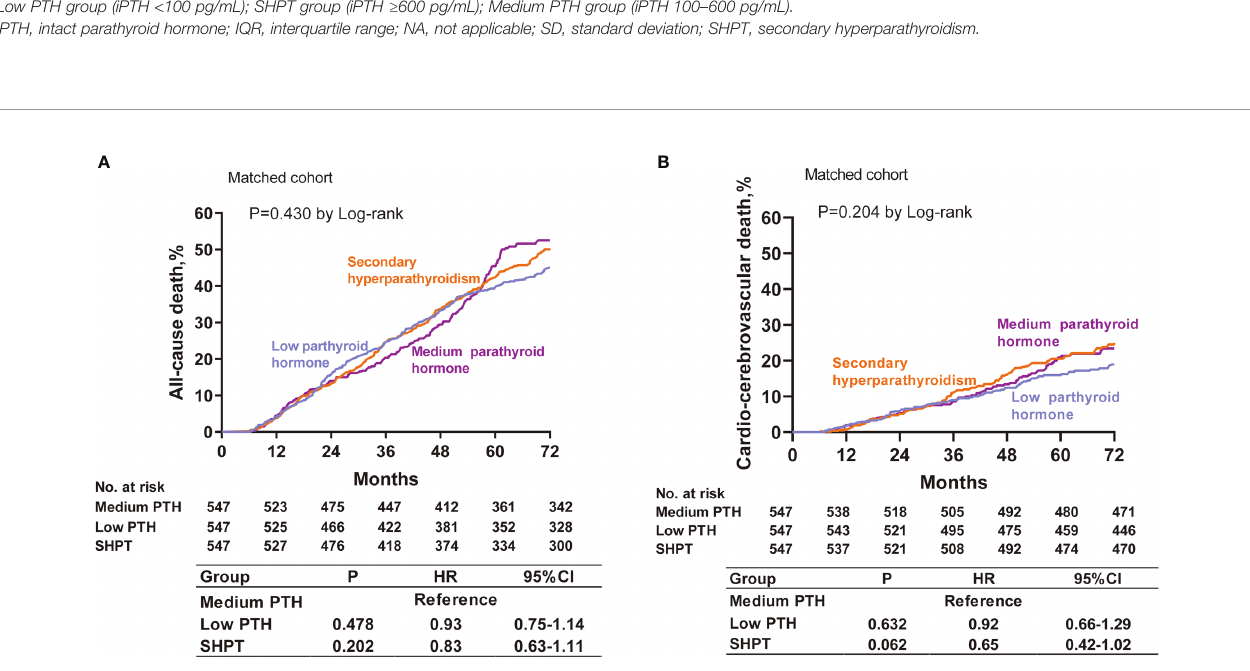
FIGURE 4 | Cumulative event rates at 72 months for all-cause death (A) and cardio-cerebrovascular death (B) among patients with low PTH, medium PTH, and SHPT in the propensity-matched cohorts. Hazard ratios are based on multivariable Cox regression analyses. PTH, parathyroid hormone; SHPT, secondary